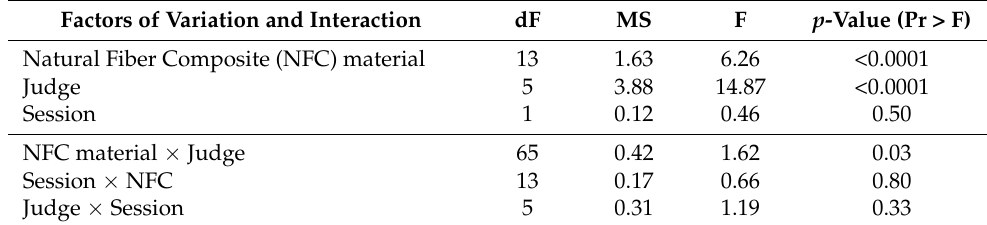
Table 3. Results of the three-way analysis of variance (ANOVA) with interaction. Factors of Variation and Interaction dF MS